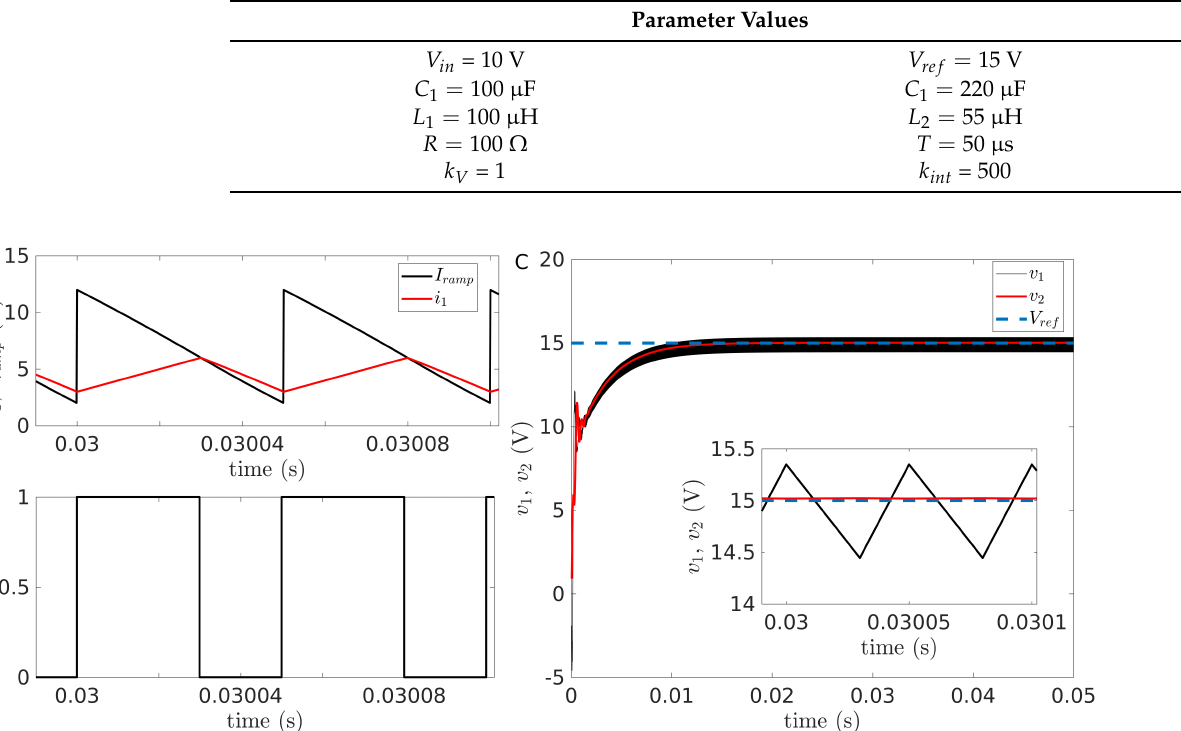
Figure 2. ( A ) Dynamics of the ramp compensation I ramp and current i 1 showing the transitions of the switch; ( B ) Position of the switch as a function time; ( C ) Evolution of the voltages v 1 and v 2 with the reference voltage in dashed lines. Inset: Steady state evolution of the voltages across the capacitors showing a good agreement of v 2 with V ref . To solve this system, a fourth-order Runge–Kutta method with variable step method was used with an event detection